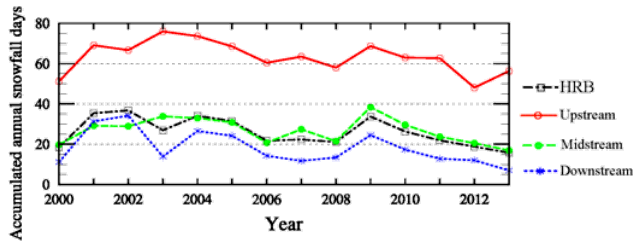
Figure 7. Mean annual number of snow days from 2000 to 2013.